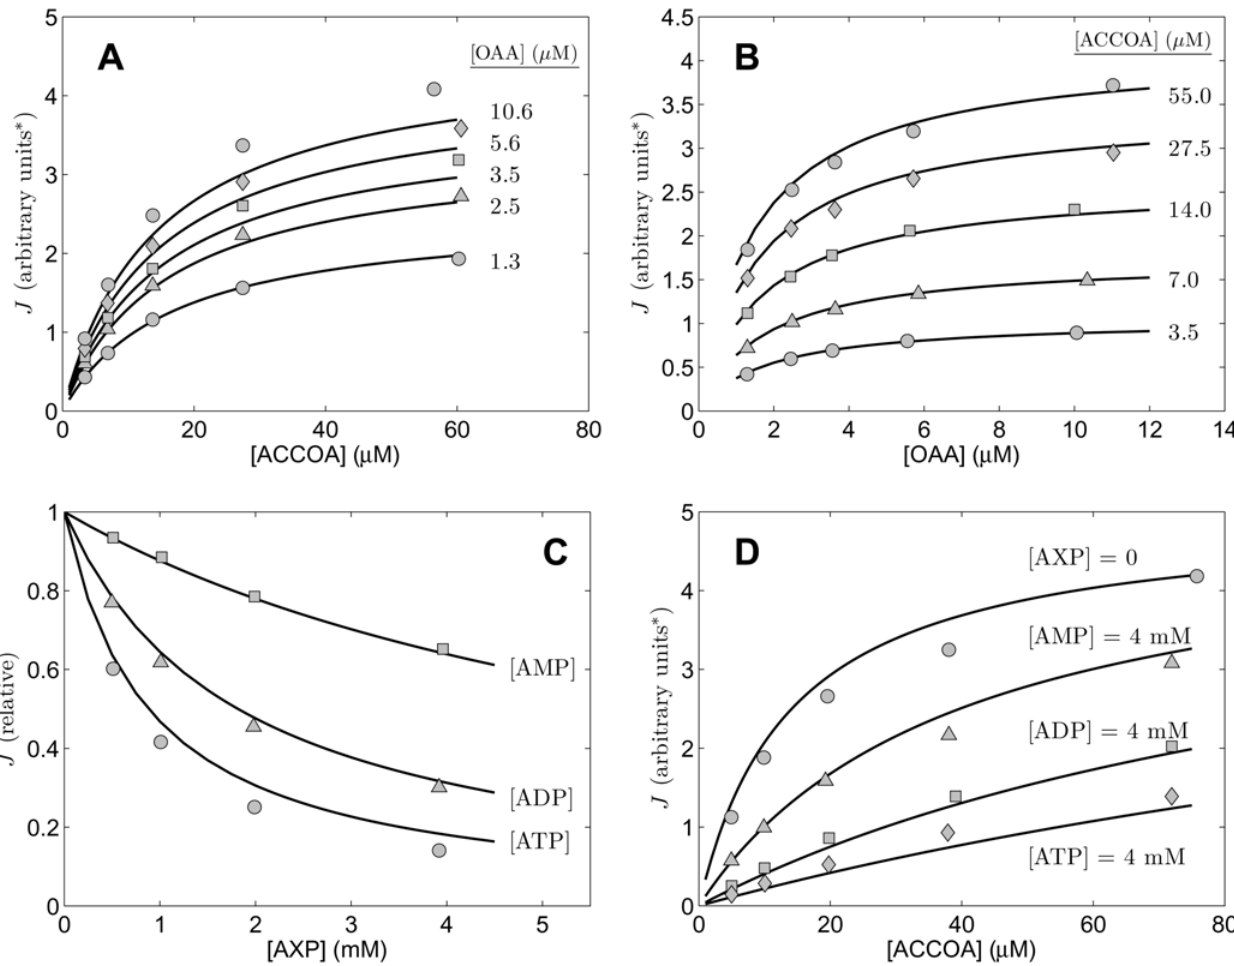
Figure 4. Fits to kinetic data from [ 15 ] on the forward operation of liver enzyme. Measured flux in arbitrary units was obtained from Figures 1,2,5, and 6 of [15]. For all cases the product (CIT and COASH) concentrations are zero and total substrate and inhibitor concentrations are indicated in the figure. A and B report data obtained with no inhibitors present. C . The relative activity (normalized to its maximum) of the enzyme is plotted as functions of [ATP], [ADP], and [AMP] measured at [ACCOA]=11 m M and [OAA]=1.9 m M. D . The measured flux is plotted as a function of [ACCOA] at [OAA]=34 m M with ATP, ADP, and AMP present as indicated in the figure. All data were obtained at pH=7.4 at 25 u C. Model fits are plotted as solid lines.